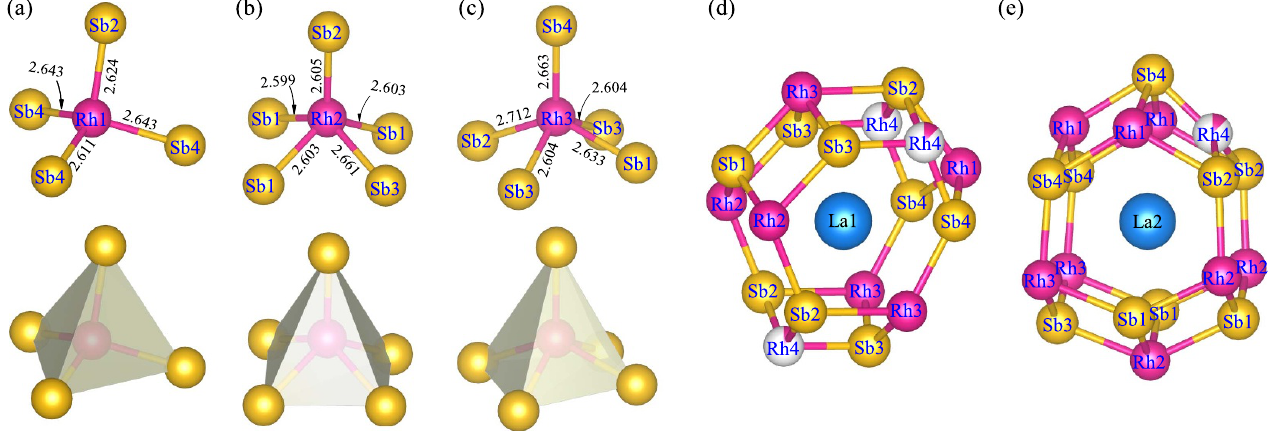
Figure 3. Local environments in La 2 Rh 3 + δ Sb 4 , (a) for Rh1, (b) for Rh2, (c) for Rh3, (d) for La1, and (e) for La2. The bond lengths are in